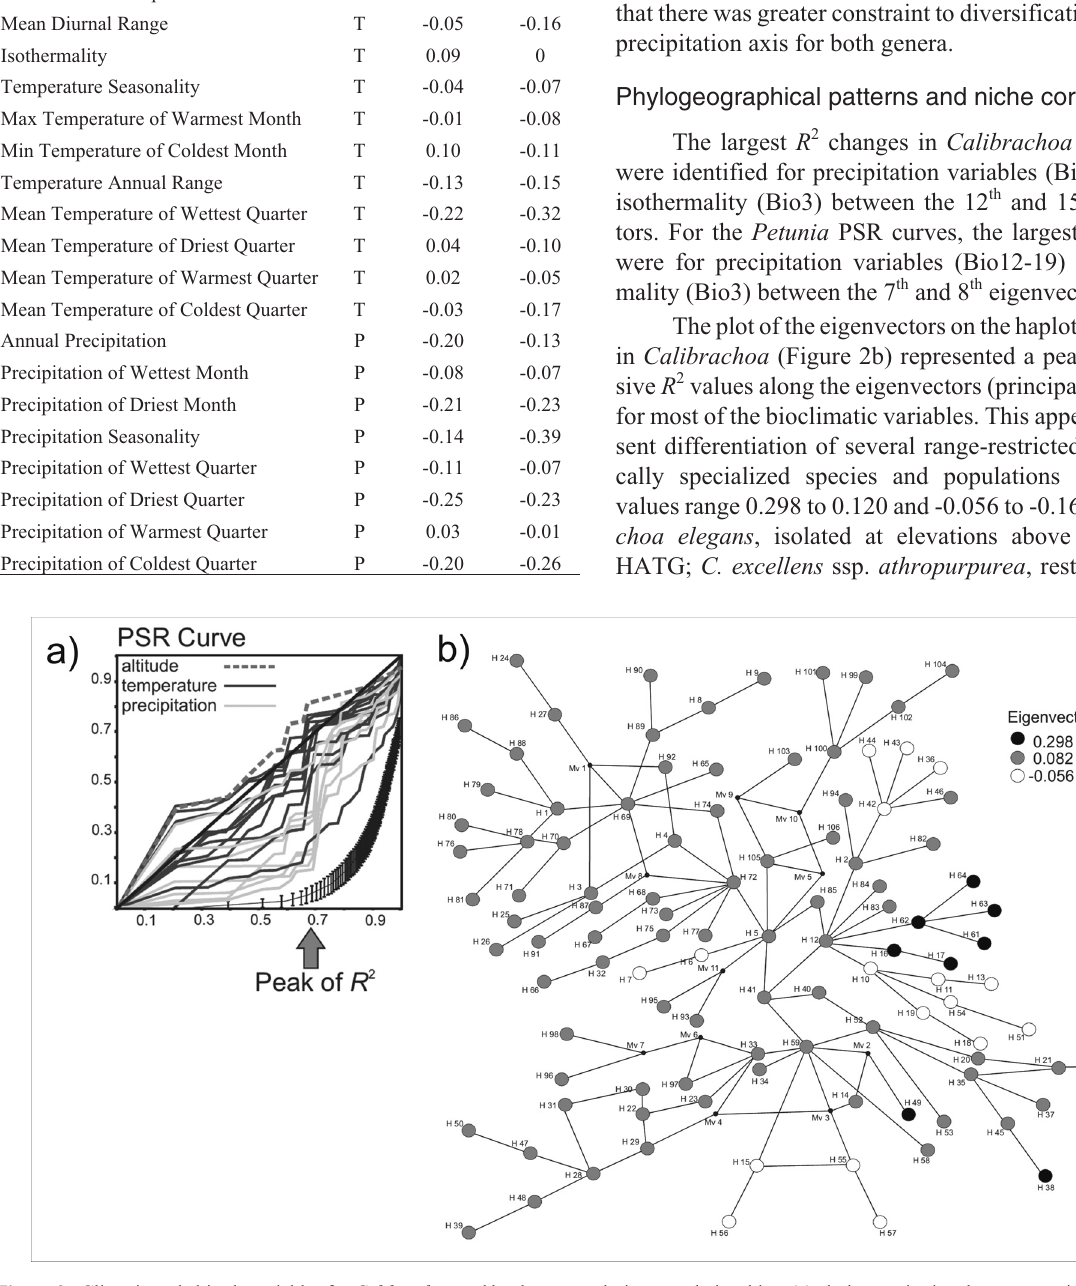
Figure 2 - Climatic and altitude variables for Calibrachoa and haplotype evolutionary relationships: (a) phylogenetic signal-representation (PSR) curves ofaltitude(dashedline),temperature(blacklines),andprecipitation(lightgraylines)variables.ThelowermostcurvewiththeverticalbarsisthenullPSR curve,representingtheabsenceofphylogeneticpatternsinthedata,obtainedfrom100randomizations.Thediagonalsolidlinerepresentstheexpectation underBrownianMotionevolution.(b)HaplotypeconnectivitynetworkbasedoncpDNAintergenicspacers trnH-psbA and trnS-trnG distancematricesin Calibrachoa . Haplotypes are consecutively numbered, with node shades representing the 12 th PCoA eigenvector, which showed the greatest R 2 shift (see Table 3 for haplotype details for each species). Eigenvectors choice was based on dramatic changes in the of correlation values, giving origin to the classes that were plotted in the